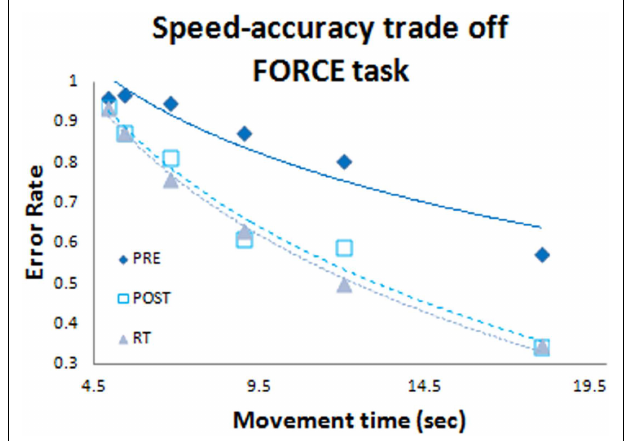
FIGURE 2 | Speed-accuracy tradeoff function . Blue diamonds represent the pre test data set; white squares represent the post test data set; and grey triangles represent the retention data set. Data were included from all subjects (both anodal-tDCS and sham-tDCS